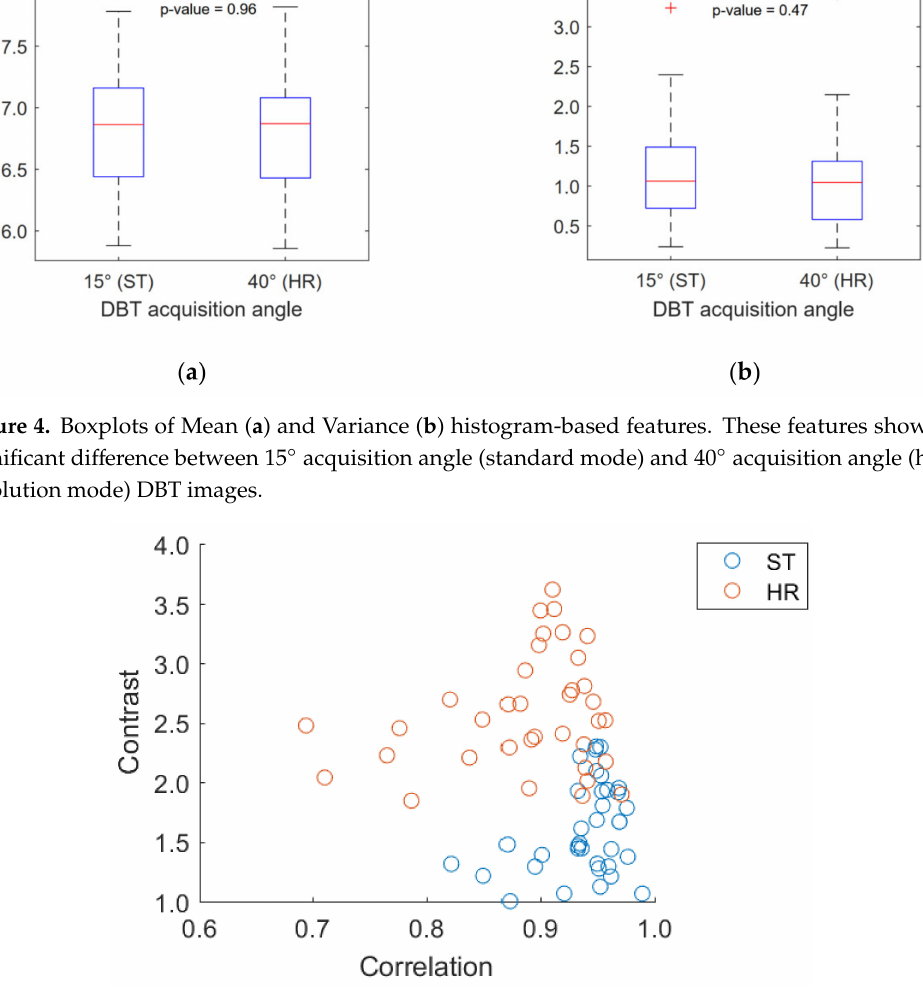
Figure 5. Scatter plot of Correlation vs. Contrast, the two most relevant features, showing the distribution in 2D space of the two imaging